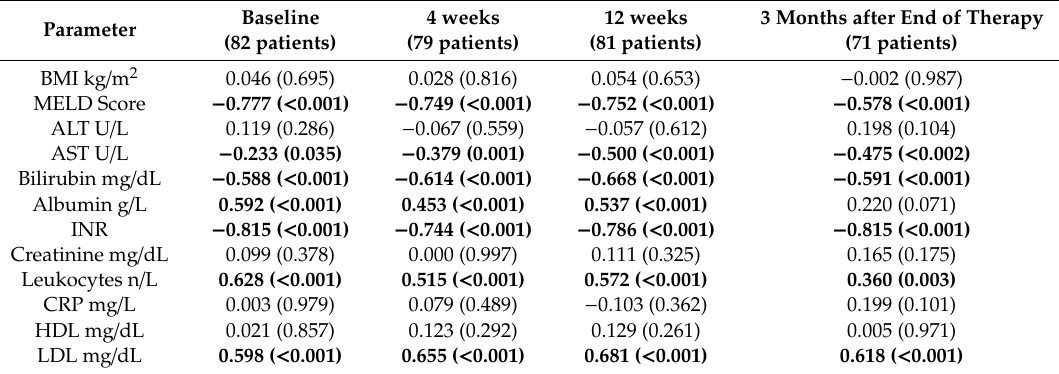
Table 1. Spearman correlation coefficients and p-values of the correlations of BMI and laboratory parameters and chemerin in the whole cohort before direct-acting antiviral (DAA) therapy, at 4 and 12 weeks after start of therapy and 3 months after the end of therapy. Significant correlations are in bold.